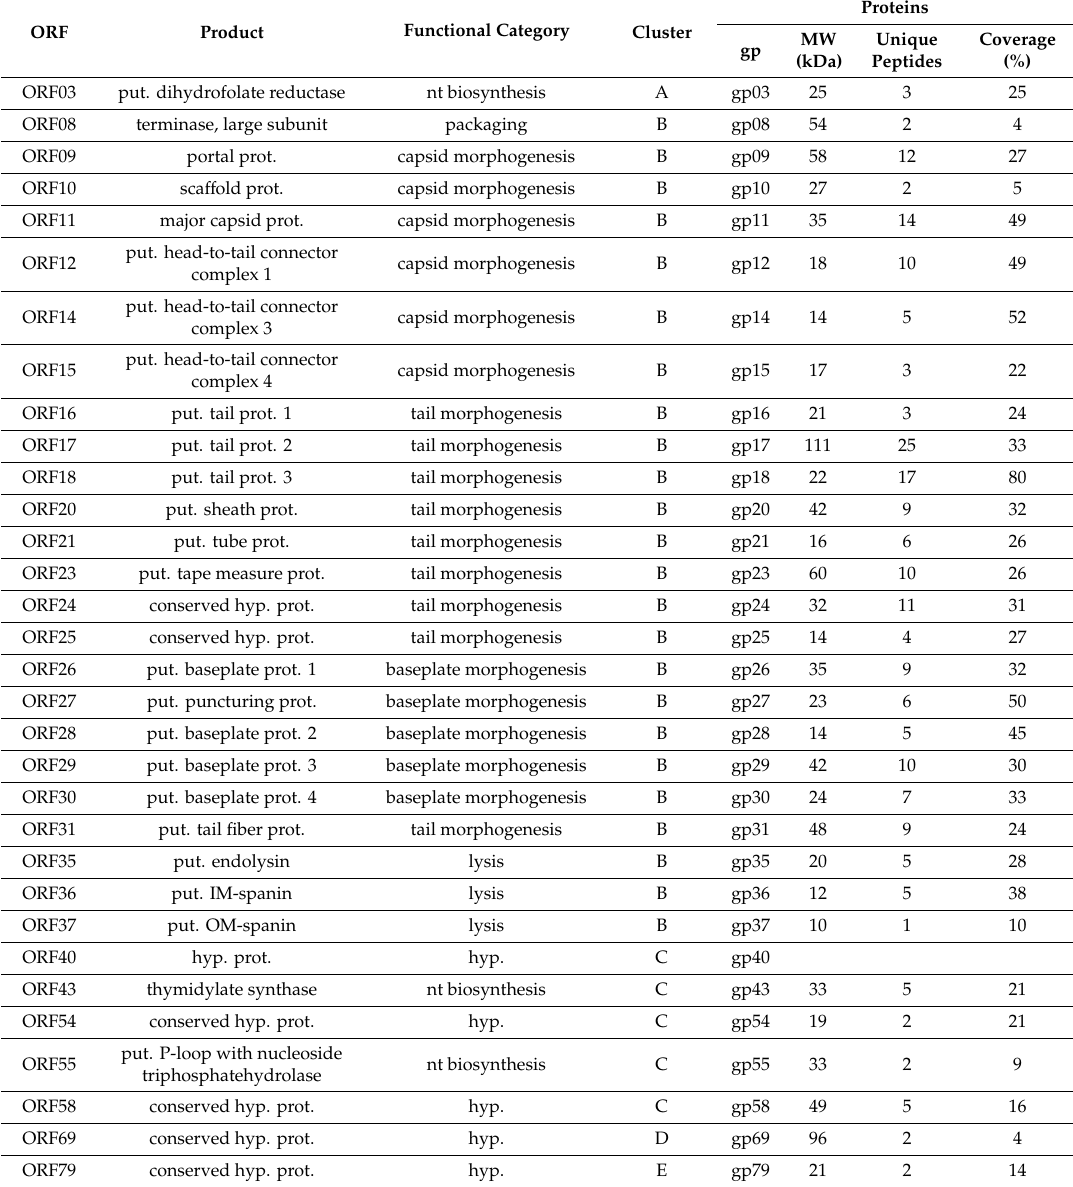
Table 2. Open reading frames (ORFs) coding for structural proteins in the genome of phage S144: their putative functions, functional category, assigned cluster; protein molecular weight in KDa, number of unique peptides and sequence coverage. The full annotation table with notes on similarities and homologies found for each predicted ORF in the databases is reported in the Supplementary